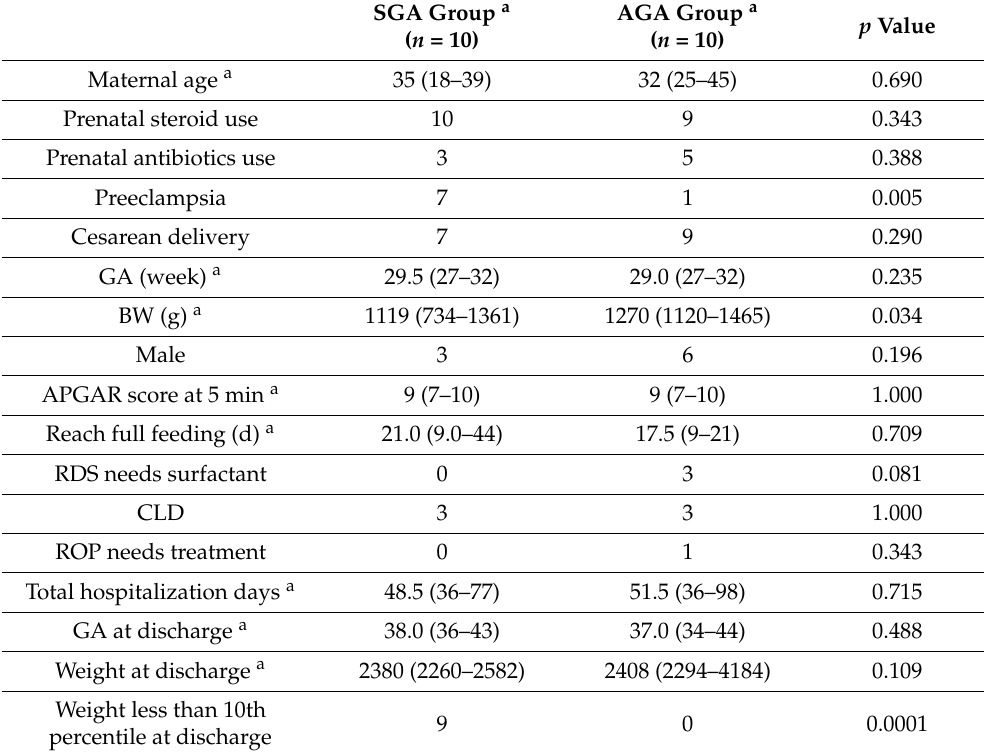
Table 1. Demographics and clinical characteristics of the